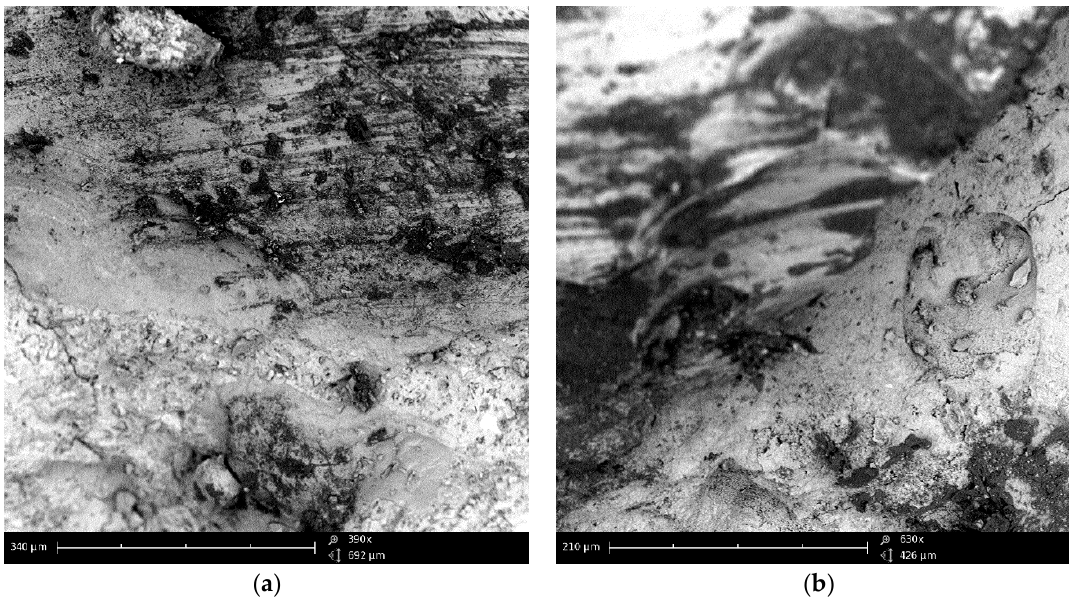
Figure 9. SEM image of the ITZ between the basalt aggregate grain and cement matrix: ( a ) magnification × 390; ( b ) magnification × 630.